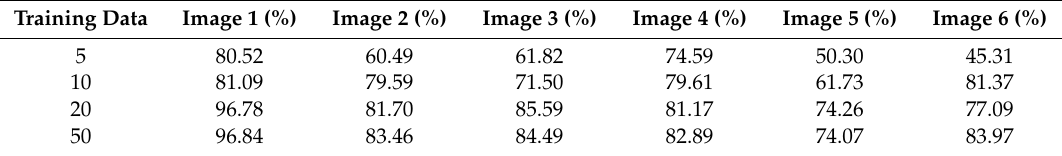
Table 4. Average classification accuracies of the proposed methodology with RGB